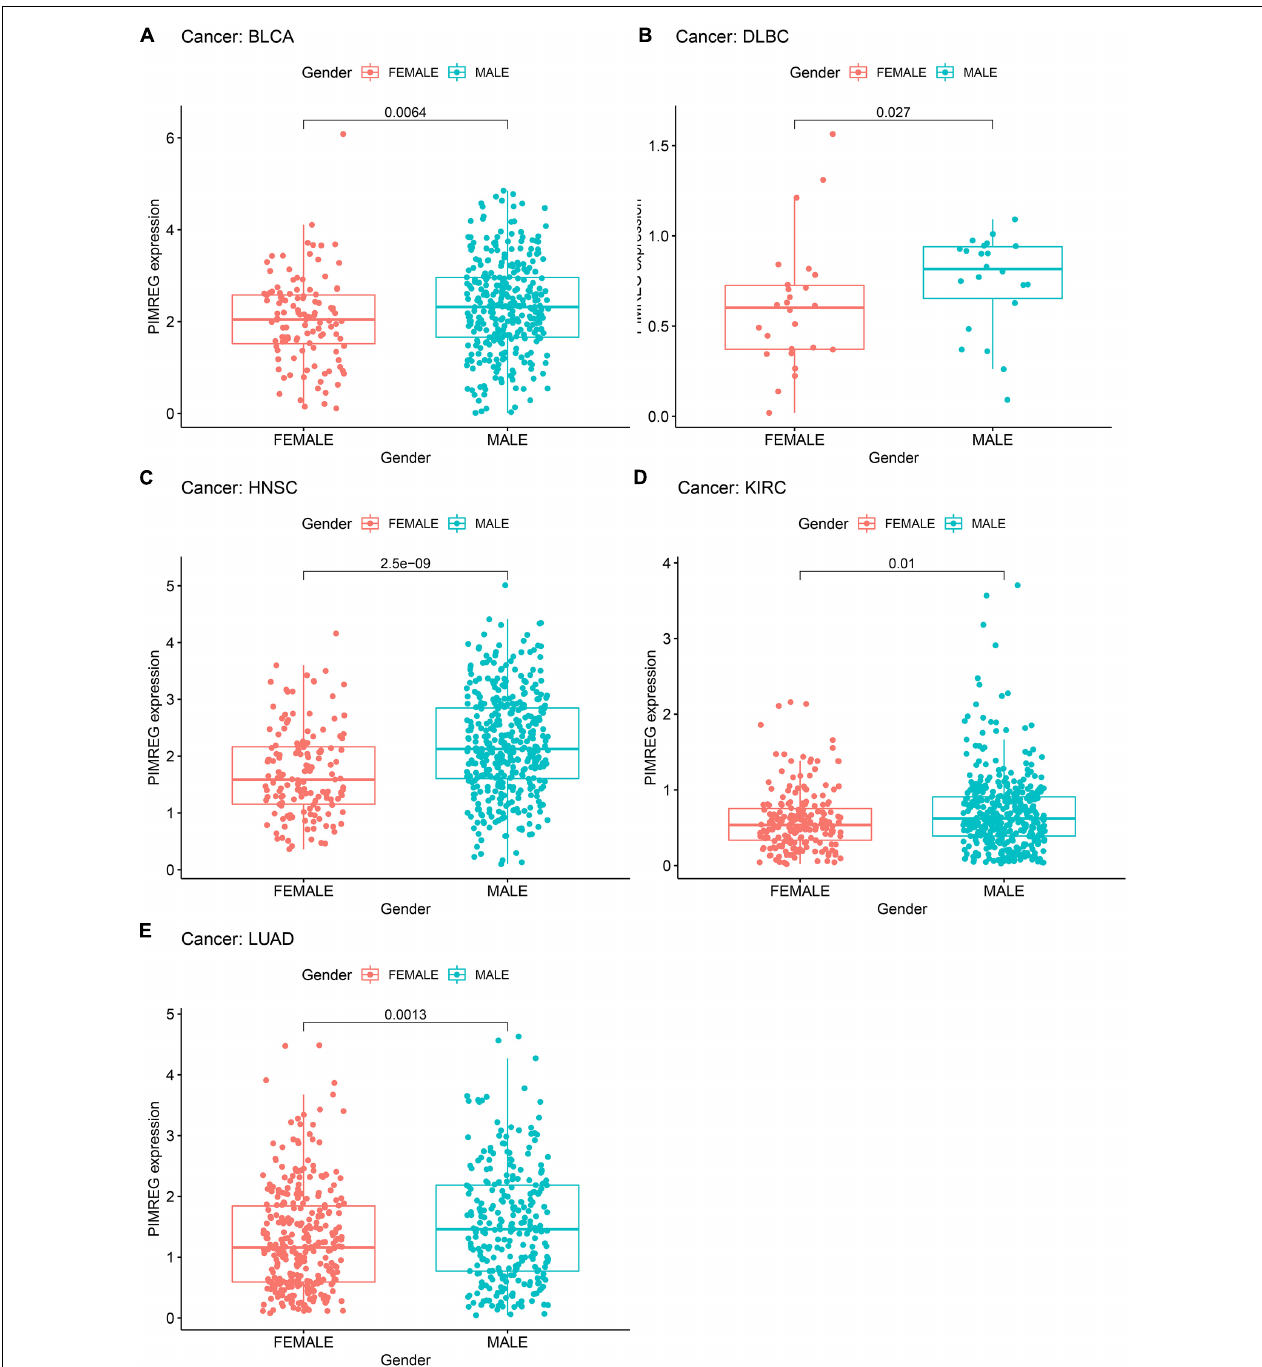
FIGURE 7 | Association of PIMREG expression with gender in panel (A) bladder cancer (BLCA), (B) large B-cell lymphoma (DLBC), (C) head and neck cancer (HNSC), (D) kidney clear cell carcinoma (KIRC), and (E) lung adenocarcinoma (LUAD).